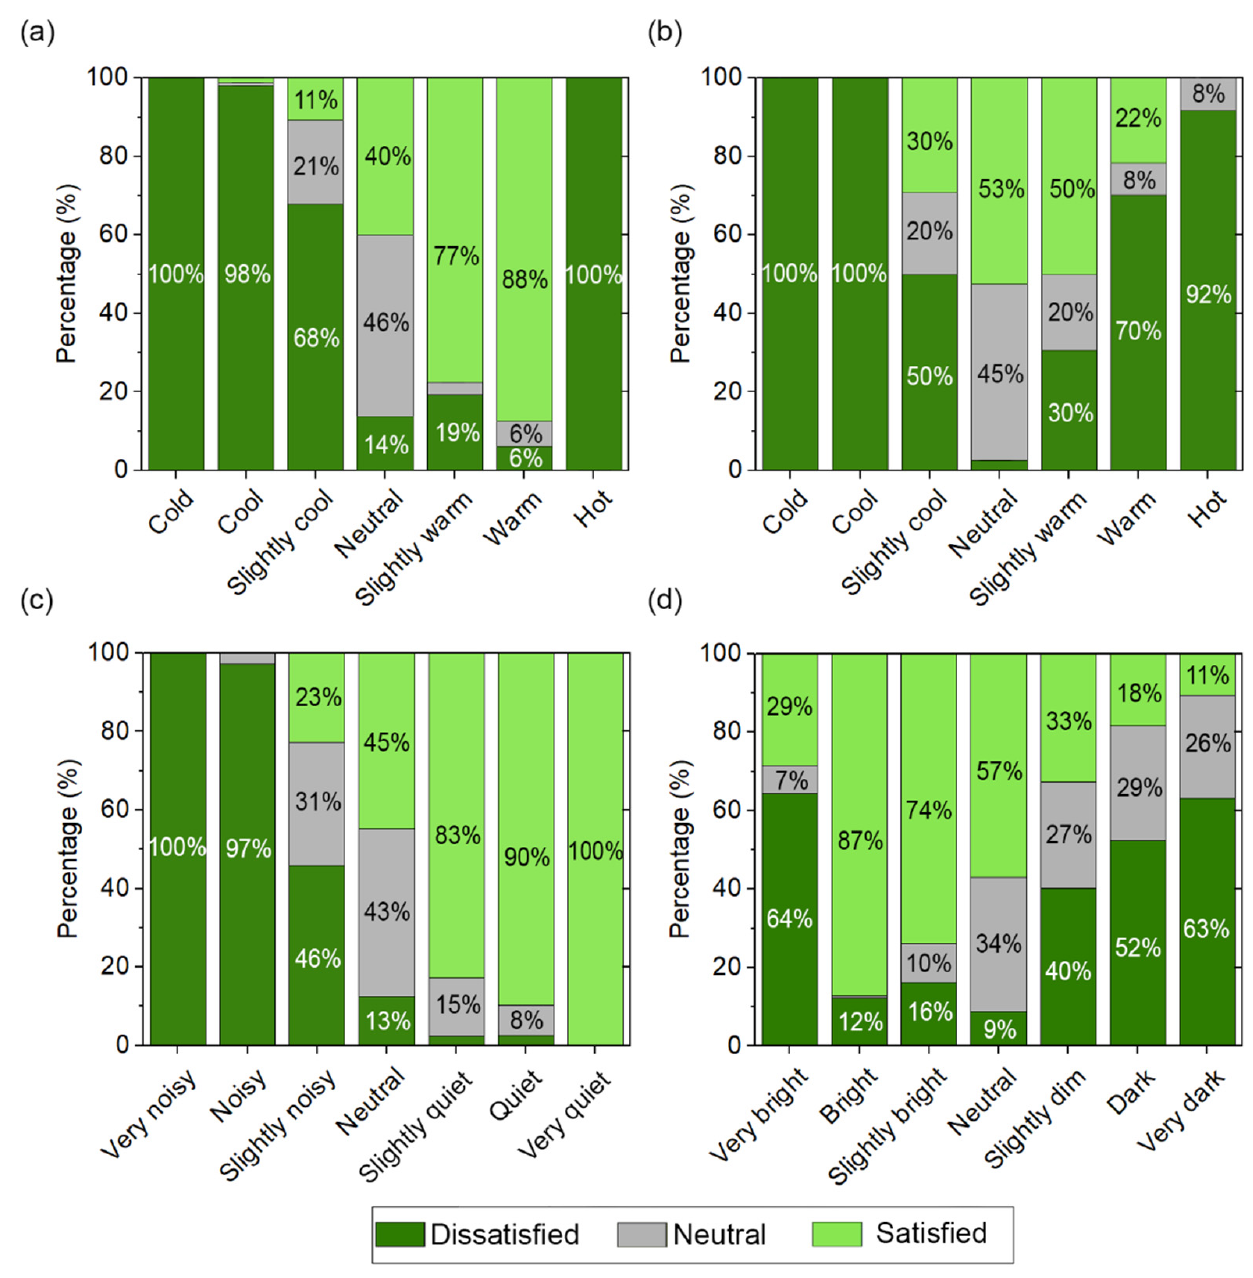
Figure 5. Sensation votes and satisfaction votes: ( a ) thermal (heating season), ( b ) thermal (non-heating season), ( c ) acoustic, ( d ) lighting.